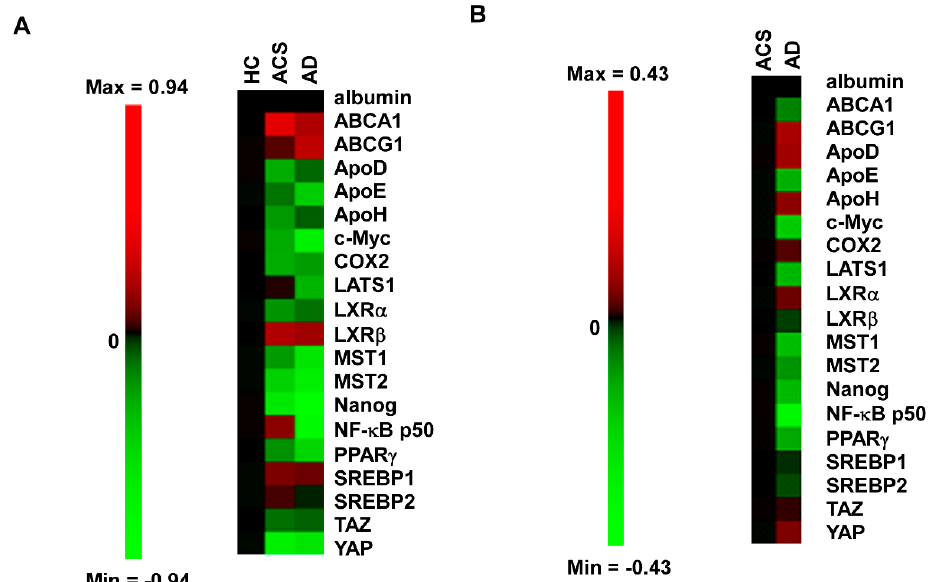
Figure 4. Expression profile of serum proteins in HC, ACS and AD participants as determined by Micro-Western Array. ( A ) The profile of serum protein profile in 31 health control samples, 30 ACS samples and 30 AD samples was demonstrated by heatmap. The average of relative expression level of the serum proteins in all 31 HC, 30 ACS and 30 AD. The heatmap was shown as log 2 value. ( B ) The profile of serum protein profile in 30 ACS samples and 30 AD samples was demonstrated by heatmap. The heatmap was shown as log 2 value. Red color indicated an increase while green color represented an decrease as compared to the standard.